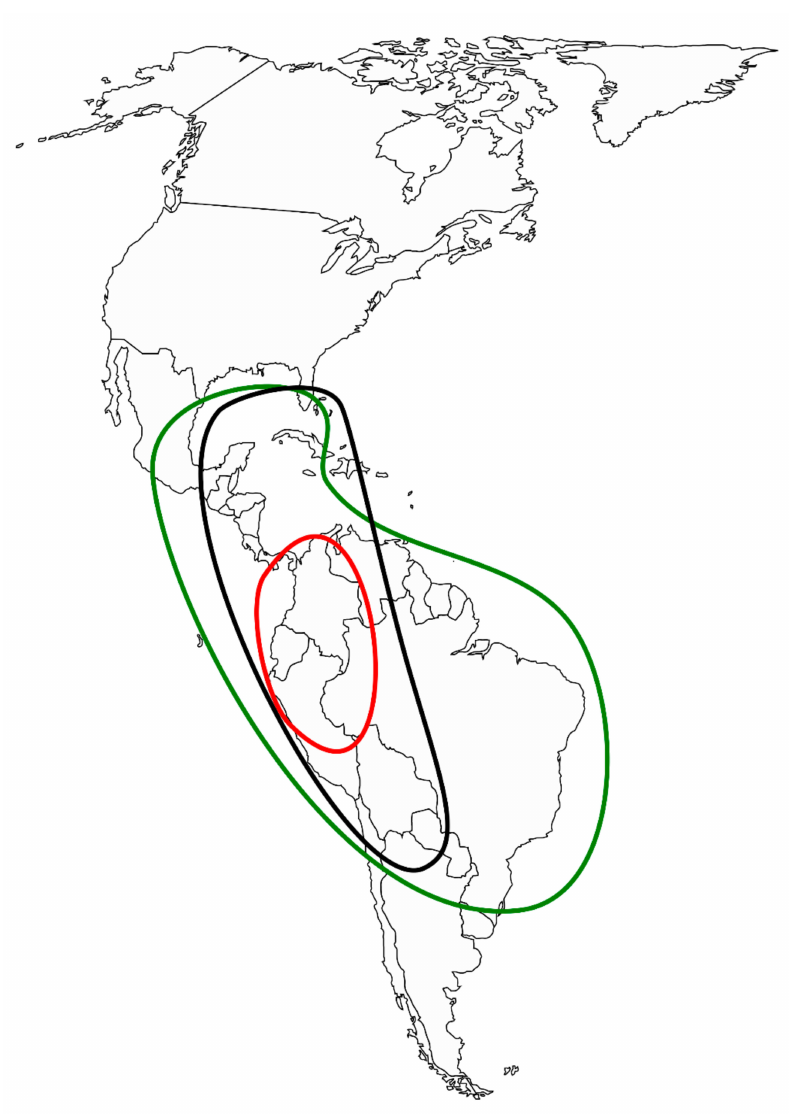
Figure 1. Geographic distribution of Picramnia (green), Alvaradoa (black), and Nothotalisia